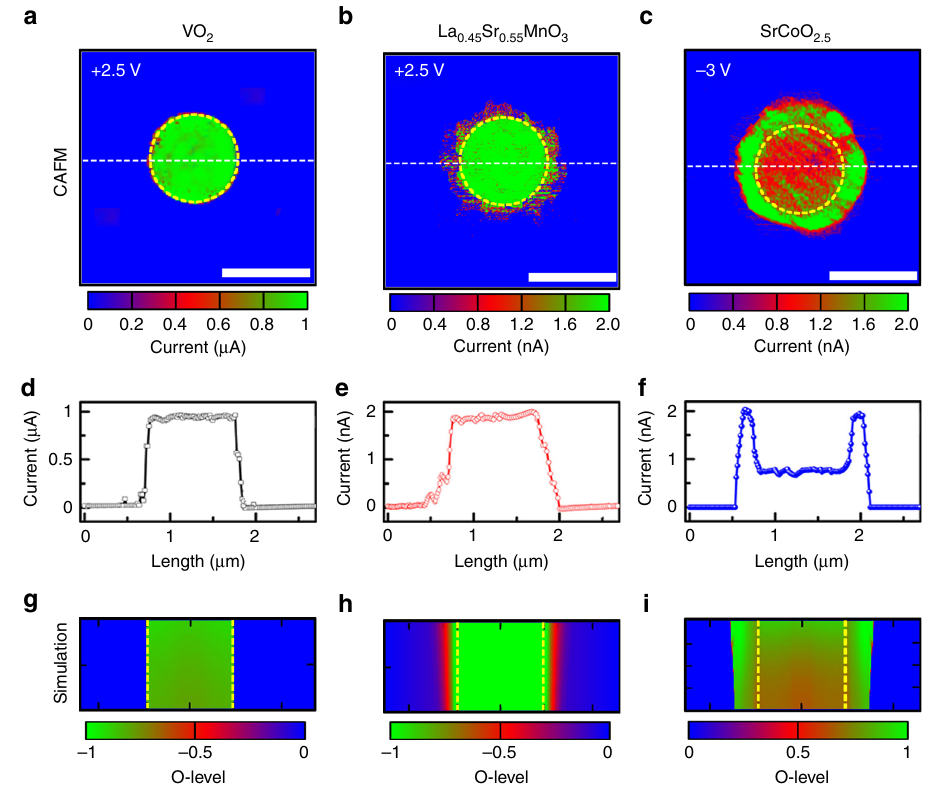
Fig. 5 3D meso-structures formed by ionic liquid gating. Typical CAFM images for a VO 2 , b La 0.45 Sr 0.55 MnO 3 , and c SrCoO 2.5 after ionic liquid gating through ori fi ces in the resist overlaid on the sample. Gate voltages of + 2.5 V for VO 2 and La 0.45 Sr 0.55 MnO 3 and – 3 V for SrCoO 2.5 fi lms were applied for 15 min. The IL and resist were then removed before CAFM measurements were carried out. Typical CAFM images of a single ori fi ce are shown. The scale bars in a – c are 1 µ m. d – f are 1D current pro fi les taken at positions indicated by the white dashed lines in a – c , respectively. Simulations of the oxygen levels (O- levels) for g VO 2 , h La 0.45 Sr 0.55 MnO 3 , and i SrCoO 2.5 after ionic liquid gating are shown for the same size region as the CAFM images. The yellow dashed lines indicate where either O 2 – ( V G = – 3 V) or V O ( V G = + 2.5 V) enters the sample. The O-level is indicated by the color gradient, as shown below each simulation. Note that color gradient is reversed for SCO as compared toVO 2 and La 0.45 Sr 0.55 MnO